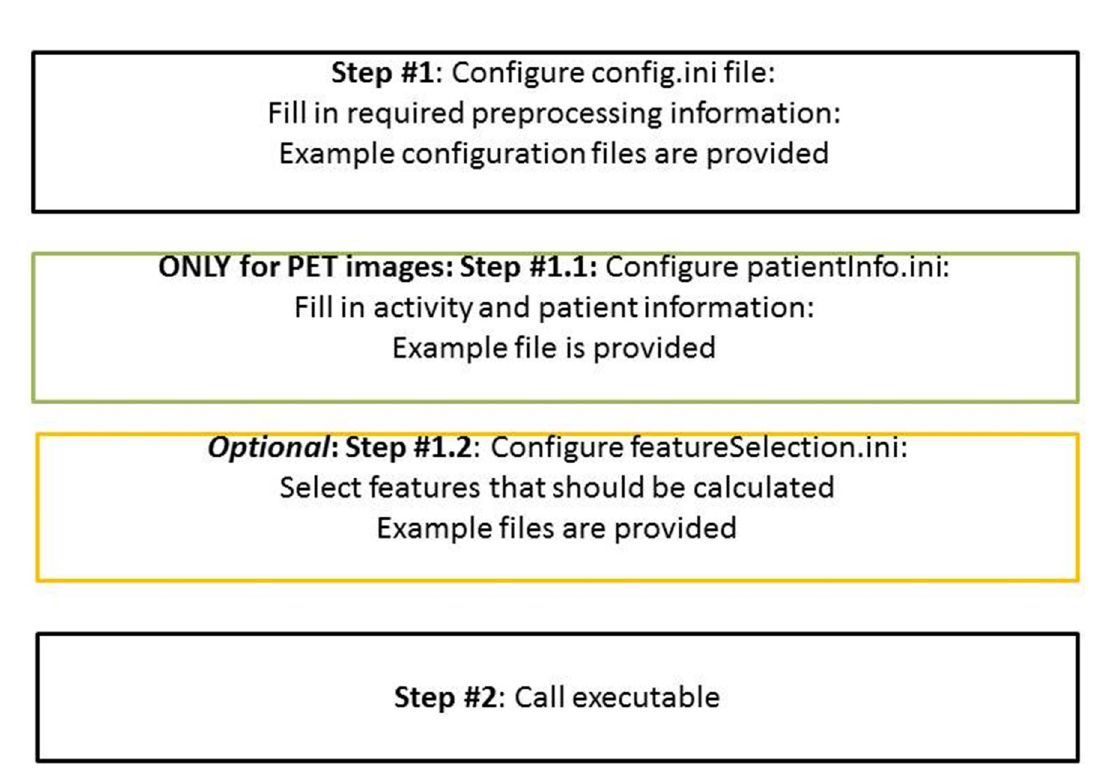
Fig 3. Necessary steps for running the